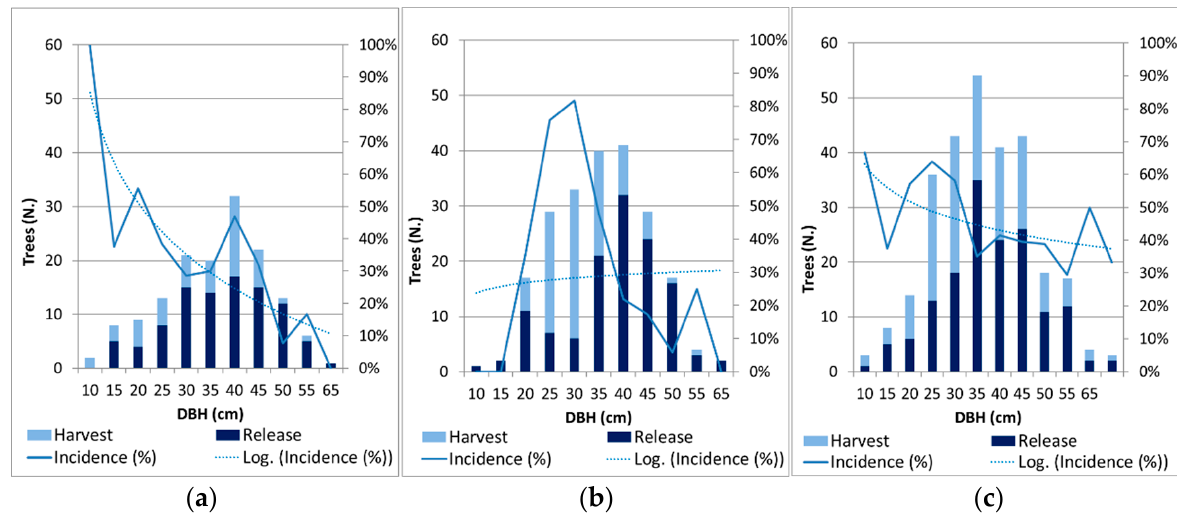
Figure 1. Impact of harvesting operations on forest stand as number of released and harvested trees, and relative incidence (Inc %, Log): ( a ) Systematic thinning; ( b ) Selective thinning; ( c ) Regeneration felling.